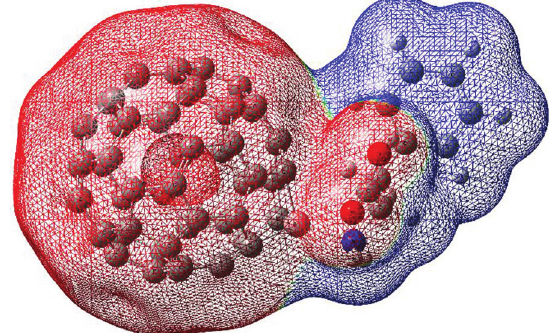
…Phe (NH ) system in gas phase. Color 59 2